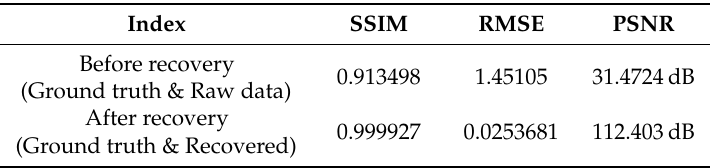
Table 3. Algorithm performance evaluation.